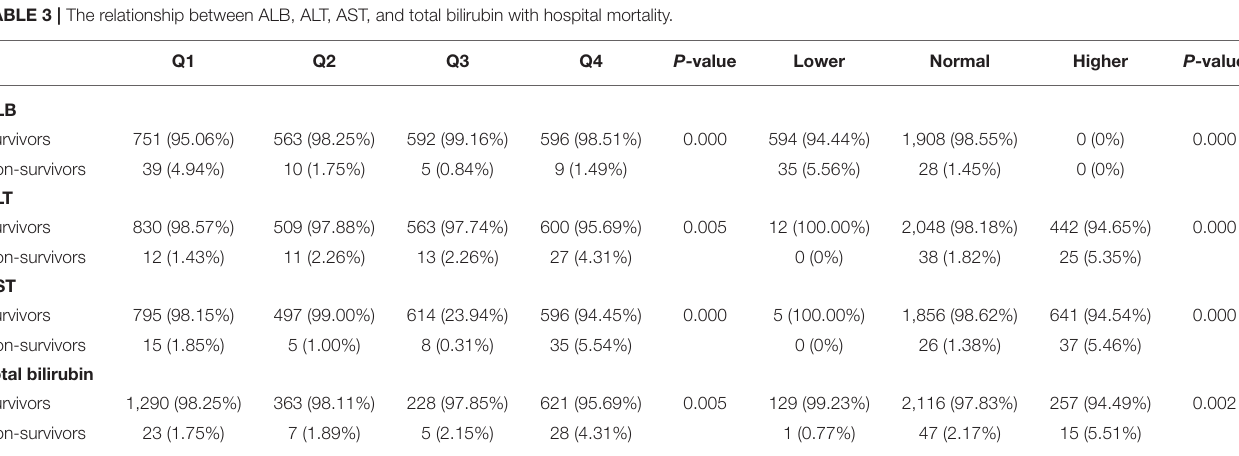
TABLE 3 | The relationship between ALB, ALT, AST, and total bilirubin with hospital mortality.